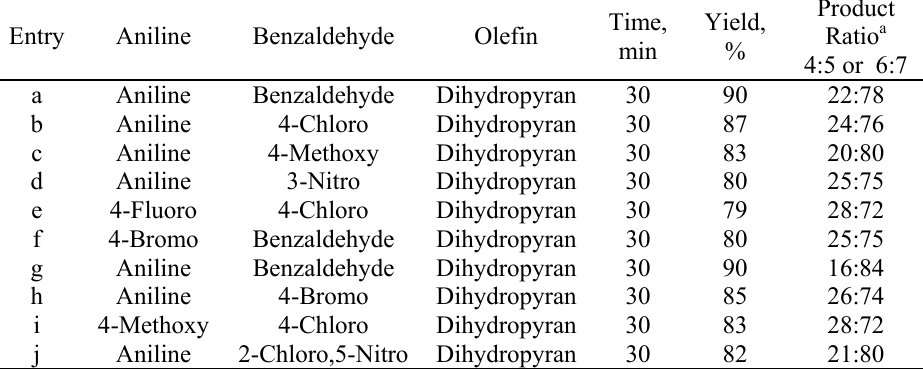
Table 2. T P -Catalyzed synthesis of pyrano- and 3